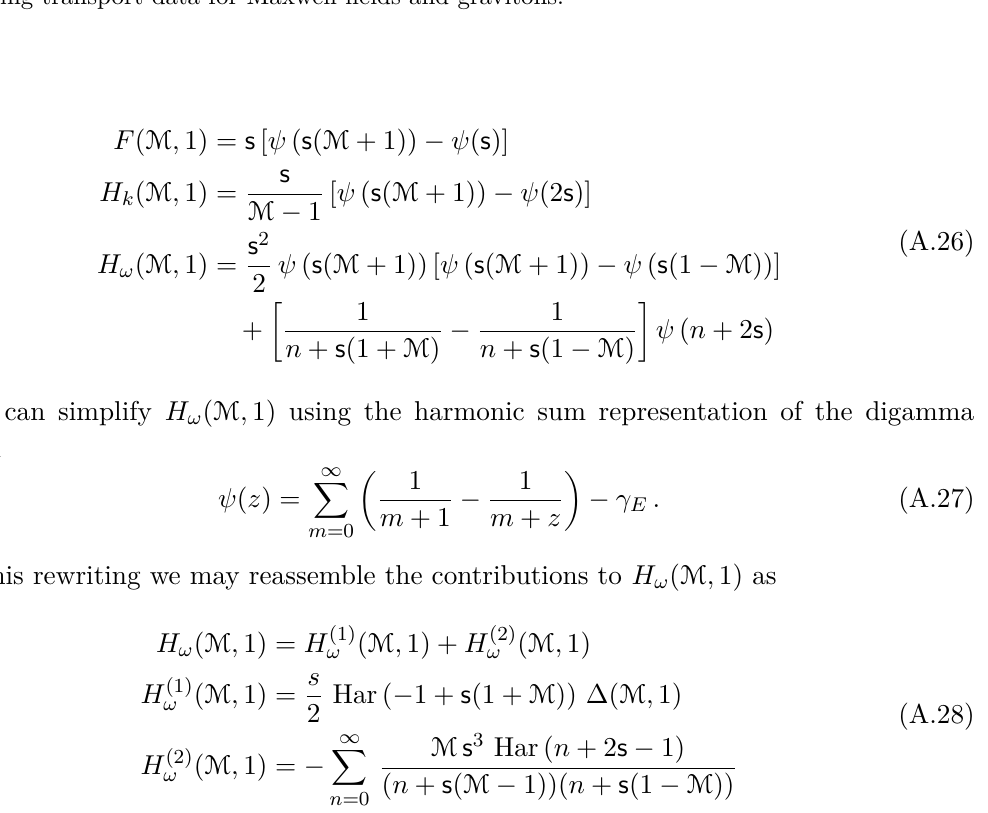
Table 2 . Horizon values of the special functions appearing in the Wilsonian influence phase and determining transport data for Maxwell fields and